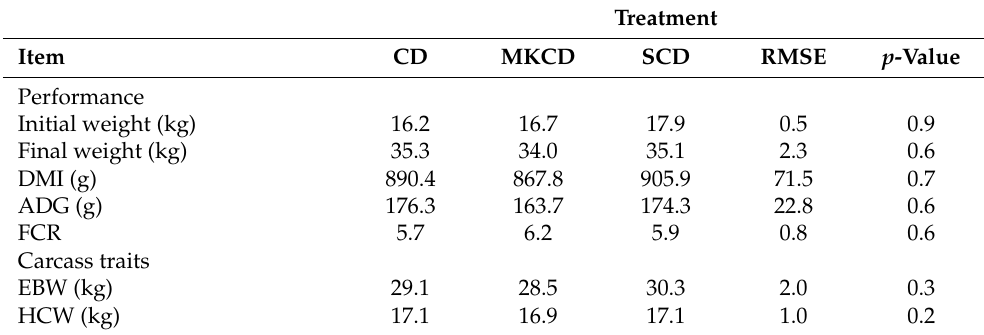
Table 6. Growth performance and carcass traits of lambs given the